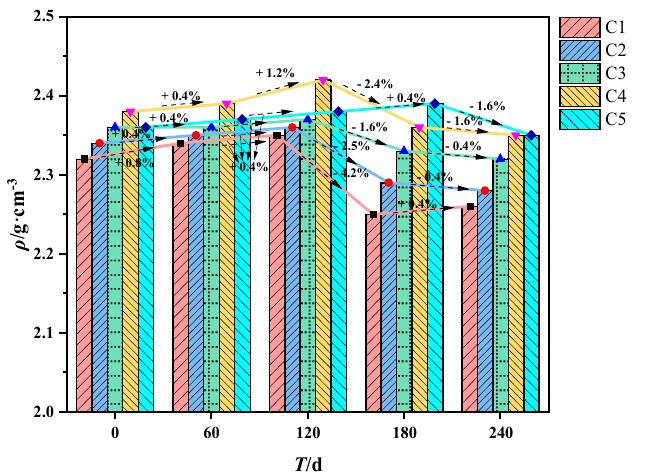
Figure 6. Concrete density variation.